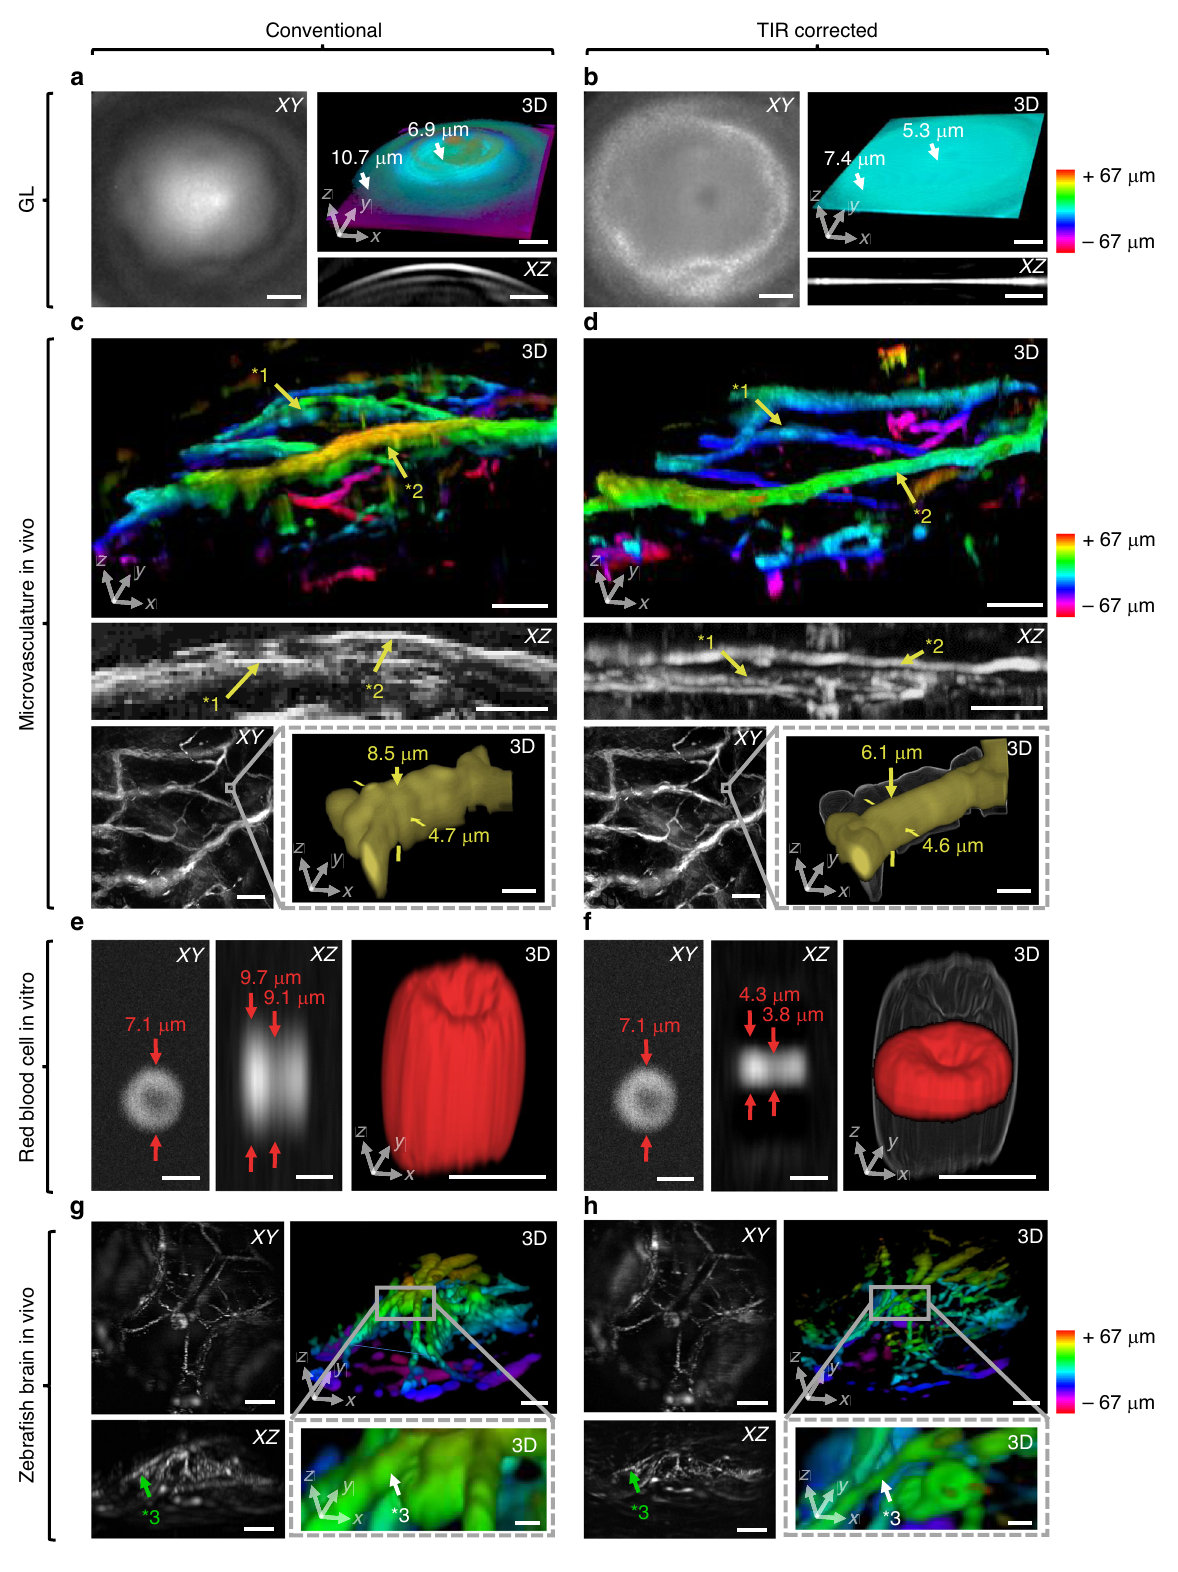
resolution features compared with conventional techniques. The new performance allows observations not before available to optoacoustic microscopy and the inspection of images with 3D accuracies not achieved so far in the fi eld. This performance is based on a TIR-characterization method that scans diffraction-